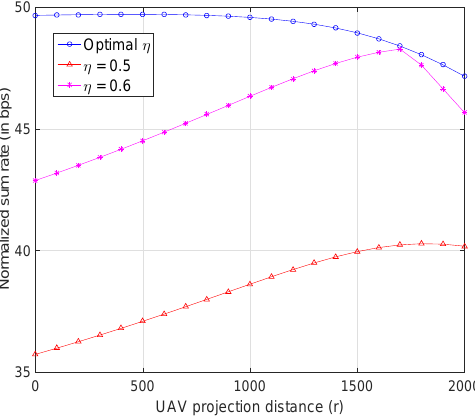
Figure 7. Normalized sum-rate versus UAV’s projection distance with different spectrum allocation.